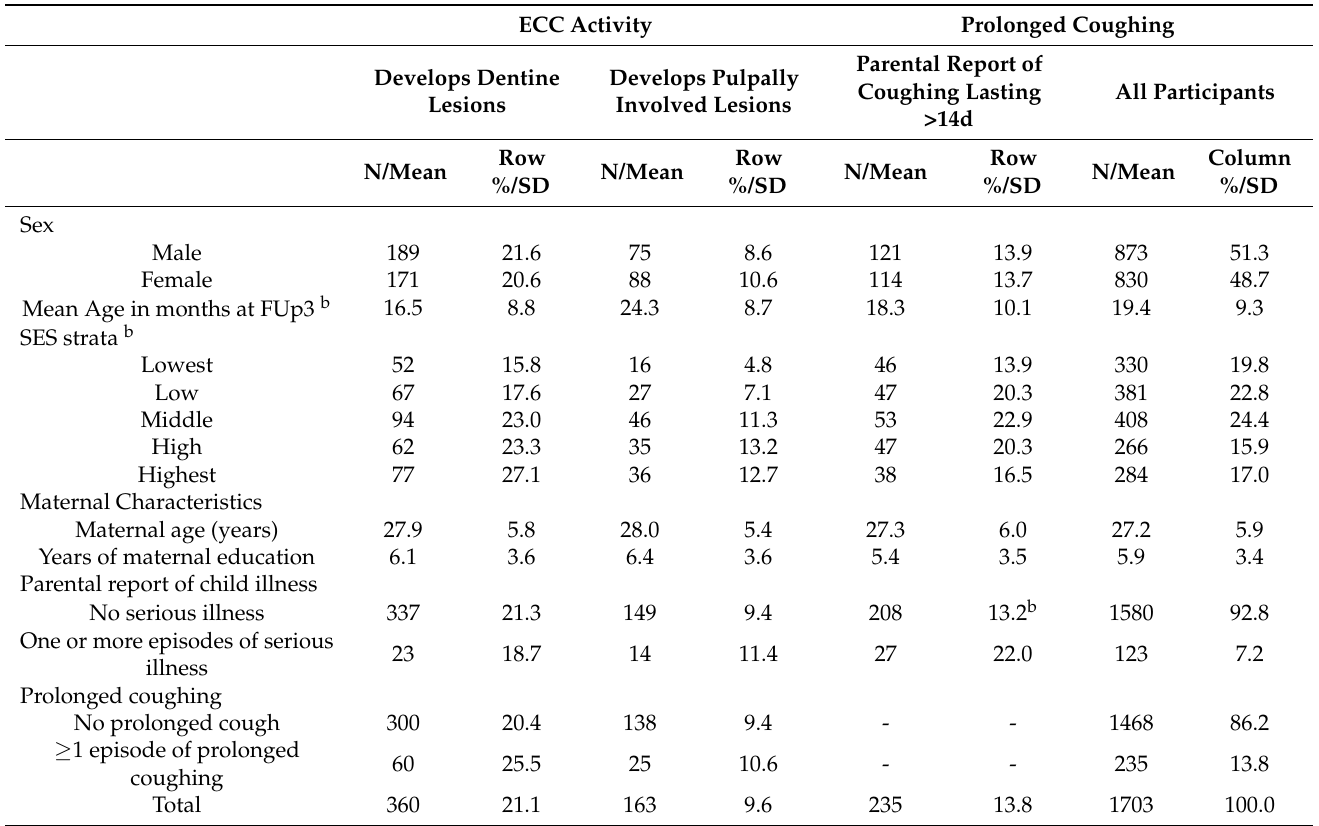
Table 1. Sociodemographic and clinical characteristics by exposure to ECC activity a